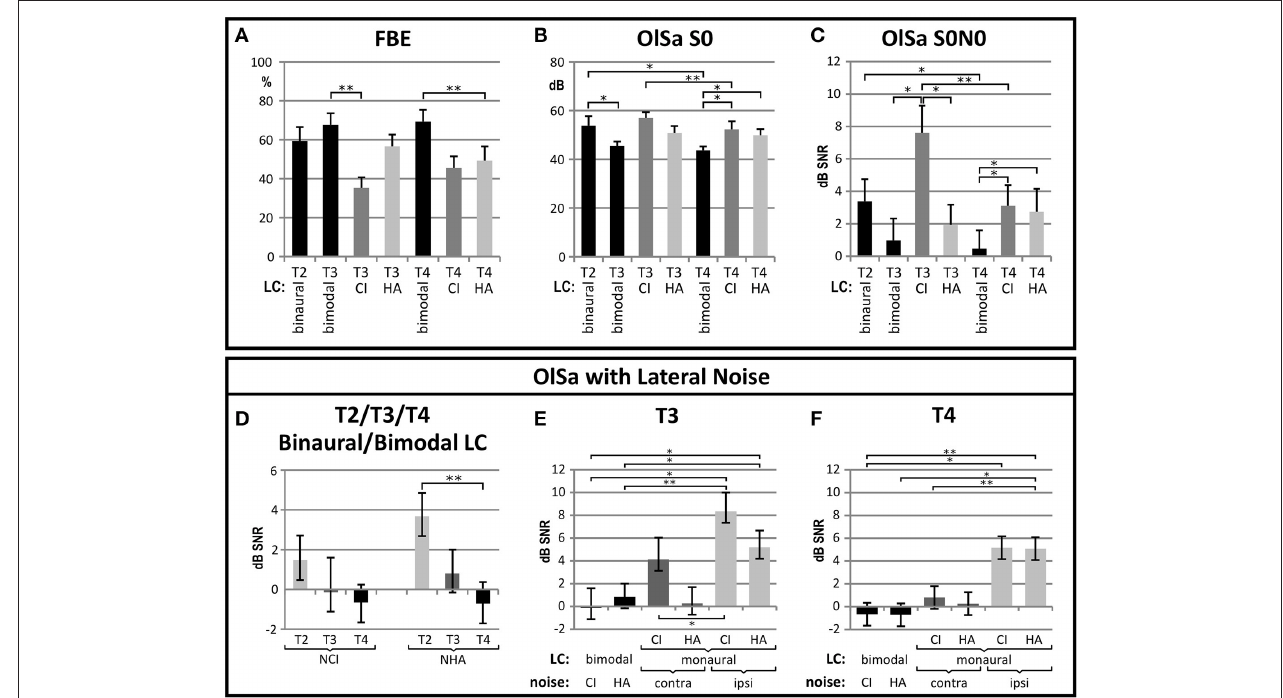
FIGURE 2 | Improvement in speech comprehension between pre- (T2) and post-CI (T3 at 3 months, T4 at 6 months) is shown for (A) monosyllables presented in quiet (FBE), (B) sentence tests in quiet (OlSa S0), and (C) sentence tests presented with noise from the same source (OlSa S0N0) or from the side of the CI (S0NCI) or HA (S0NHA) (E–F) . In all graphs, group means are shown with their respective standard error, and significant (* p < 0.05) or highly significant (** p < 0.01) differences with Bonferroni-corrected post-hoc comparisons are indicated. (A–C) Significant improvements with CI provision are evidenced for the binaural (bin) listening condition (LC), which is bimodal (bim) at T3 and T4. In addition, bimodal LC is often significantly better than monaural LC (CI or HA). (D) If noise is presented from the side of the hearing aid (S0NHA) improvement between T2 and T4 is highly significant, while change is insignificant if noise is presented at the CI-side (S0NCI). (E , F) comparisons of bimodal and each monaural LC are shown for T3 (E) and T4 (F) . Again LC indicates bimodal or monaural CI- or HA-assisted listening, and noise is presented to the CI or HA-ear for the bimodal LC, and ipsi- or contralateral to the assisted ear for the monaural LC. Performance of the CI ear improves between T3 and T4. At T4 bimodal performance is significantly better if noise is presented at the side of the monaurally assisted ear, but not with noise presented contralateral to that